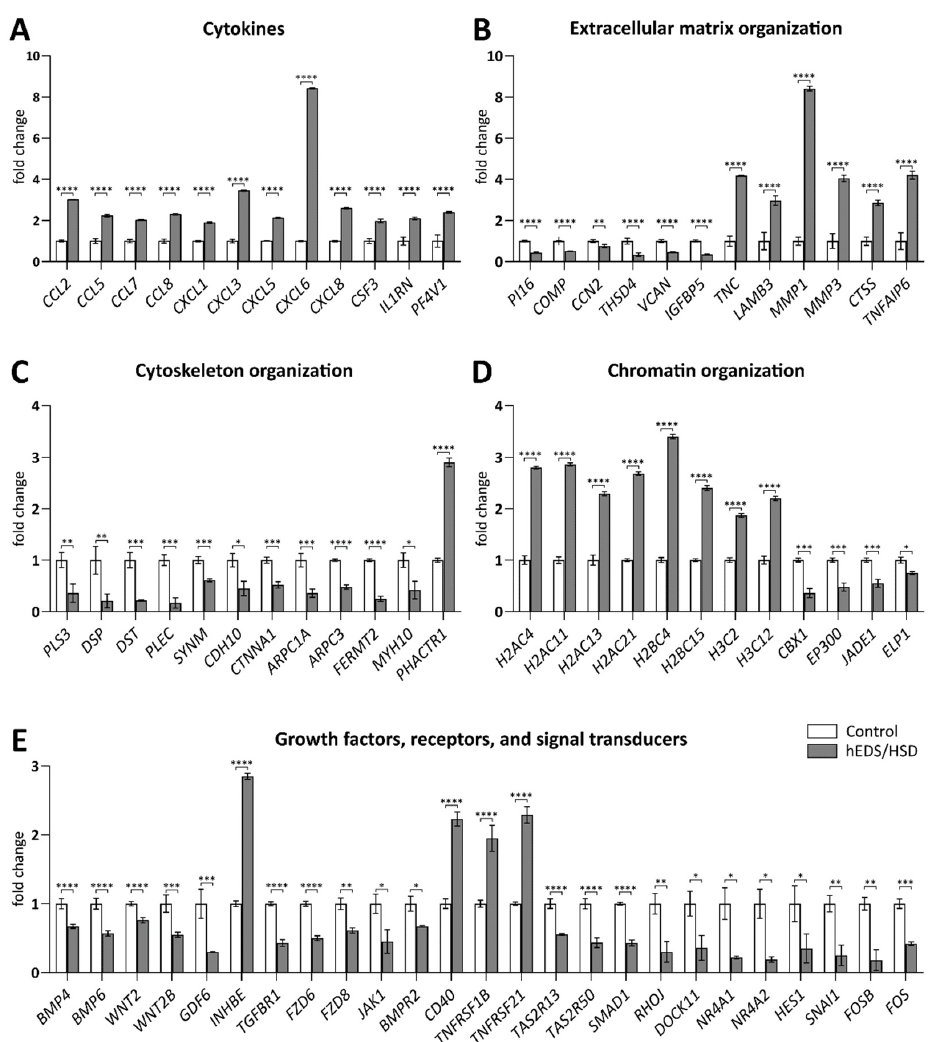
Figure 5. qPCR validation of RNA-seq data. The relative mRNA expression levels of a selection of DEGs encoding cytokines ( A ), involved in ECM organization ( B ), cytoskeleton organization ( C ), chromatin organization ( D ), and coding for different growth factors, receptors, and signal transduc- ers involved in TGF β , BMP, TNF, Wnt, VEGFA-VEGFR2, and IFN signaling pathways ( E ) were as- sessed with the 2 − ( ΔΔ Ct) method normalized with the geometric mean of different reference genes ( HPRT , GAPDH , ATP5B , RPLP0 , CYC1 ). Bars report average values of triplicates and represent the mean ratio of target gene expression from pooled RNA samples of 20 hEDS/HSD and 20 control cells. Statistical data were obtained with GraphPad Prism 8.0 by applying a two-tailed unpaired t - test and expressed as mean ± SEM. * p < 0.05, ** p < 0.01, *** p < 0.001, **** p < 0.0001.